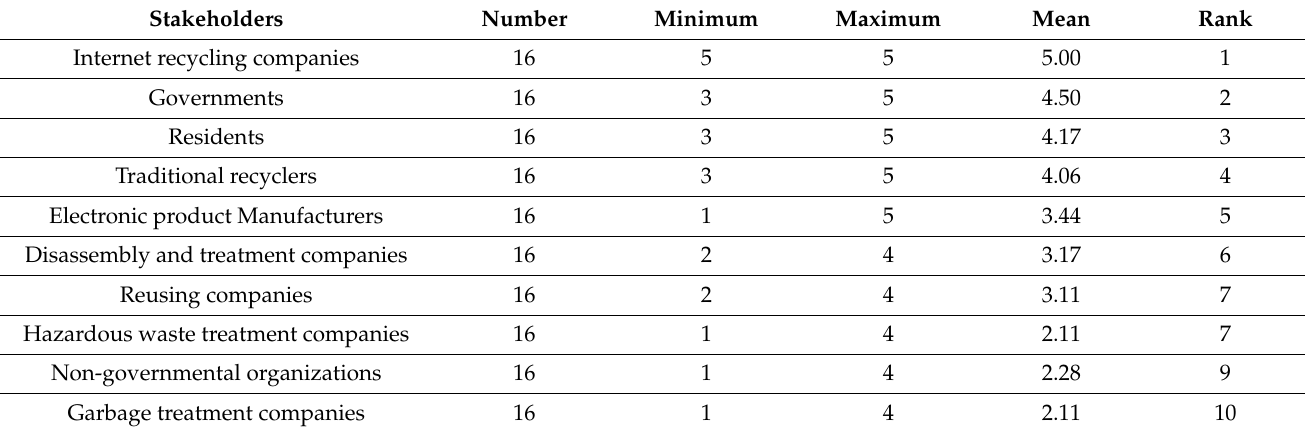
Table 5. WEEE internet recycling industry stakeholder importance